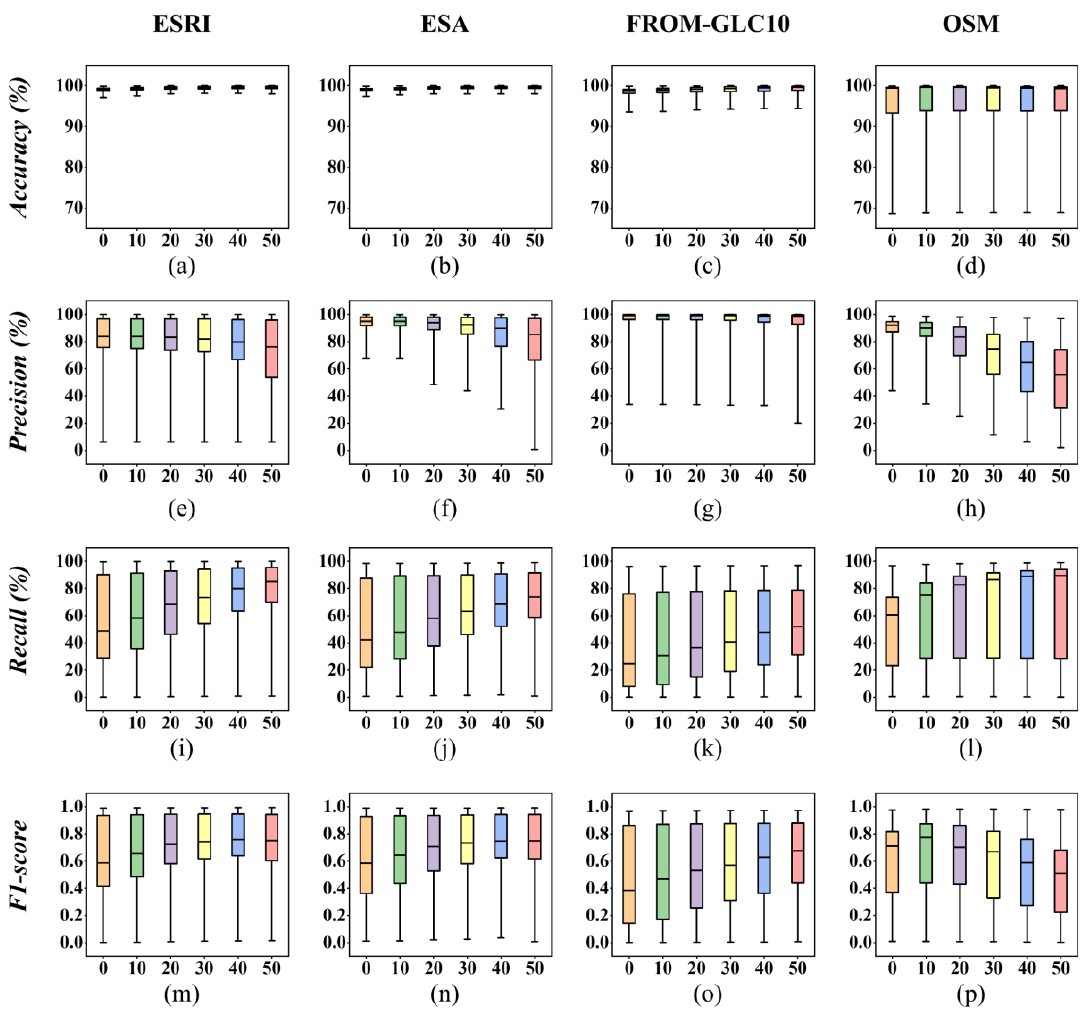
Figure 5. Comparison of the four global open LULC datasets (ESRI, ESA, FROM-GLC10, and OSM) with reference sub-datasets extracted using different buffer thresholds, visualized using box plots: